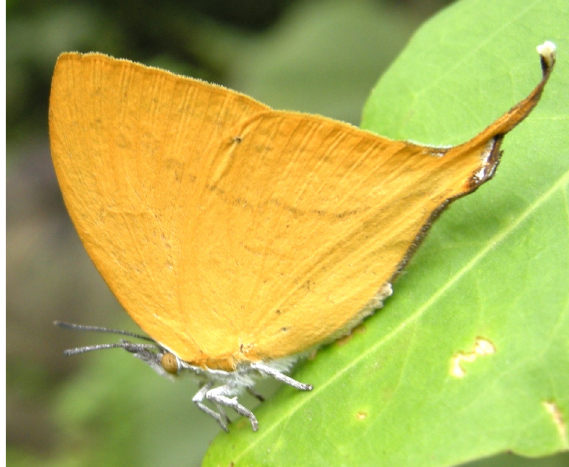
Image 11. Yamfly Loxura